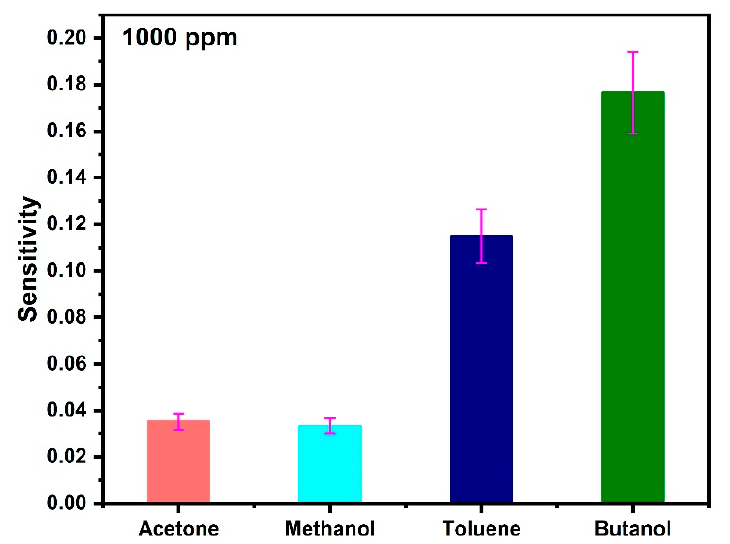
Figure 5. Histograms showing the acetone, methanol, toluene, and butanol gas responses at concen- trations of 1000 ppm.